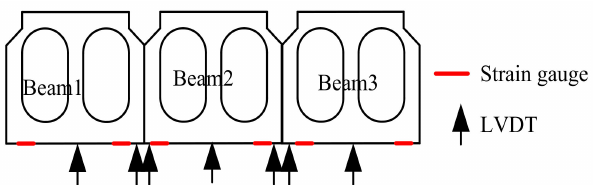
Figure 6. Layout of the strain gauge and LVDTs.